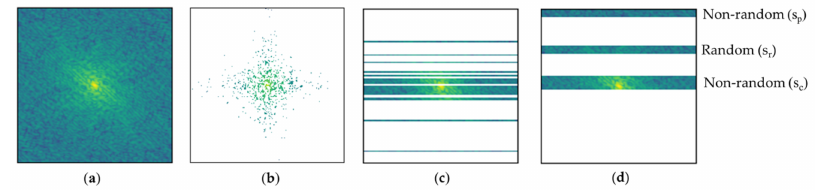
Figure 6. Several sampling patterns: ( a ) fully sampled; ( b ) 2D Gaussian pattern; ( c ) 1D Gaussian pattern; ( d ) mixed center and periphery under-sampling